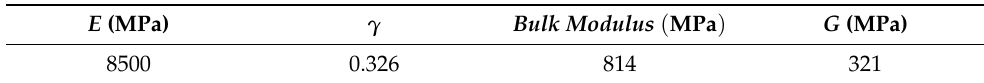
Table 2. Mechanical properties for carbon veil.